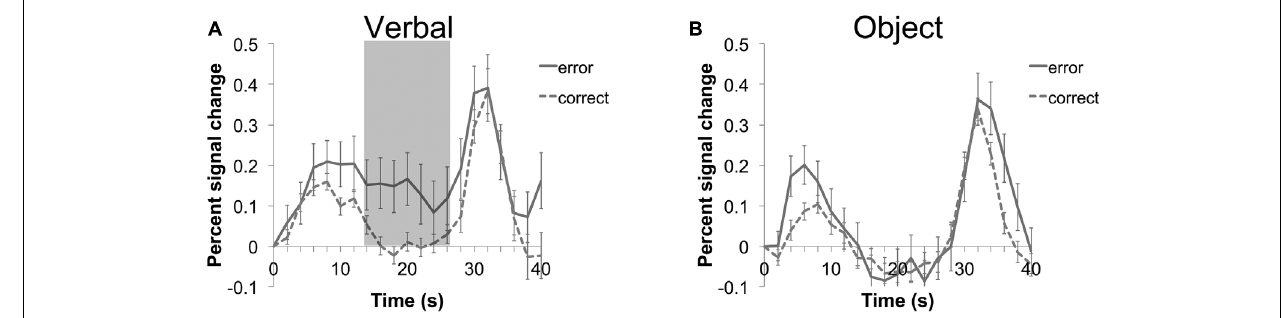
FIGURE 4 |Time course of average ( ± SEM) activity for the leftVPC during verbal (A) and object (B) trials of theWM task. Error (solid line) and correct (dashed line) trials are shown for each condition. A binary logistic